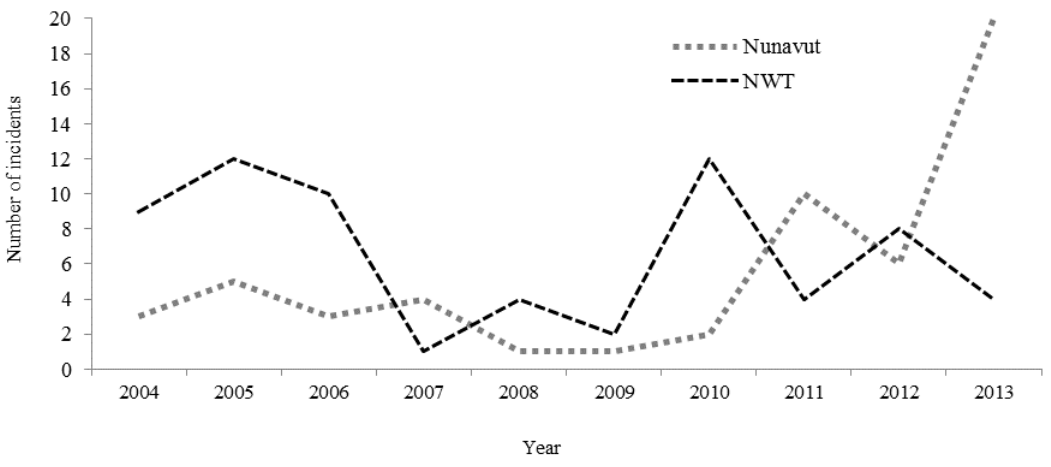
Figure 2. Number of events by year and territory.